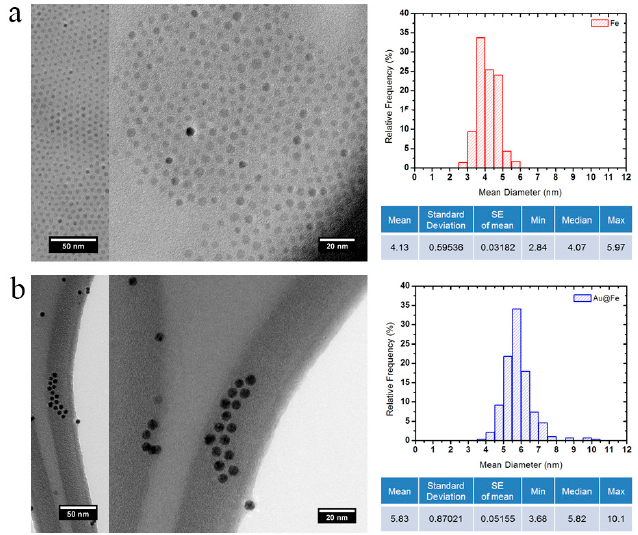
Figure 1. TEM images of the gold-coated magnetic nanoparticles, AuSPION. Images and particle size distribution of the ferromagnetic cores ( a ) and gold-coated SPION ( b